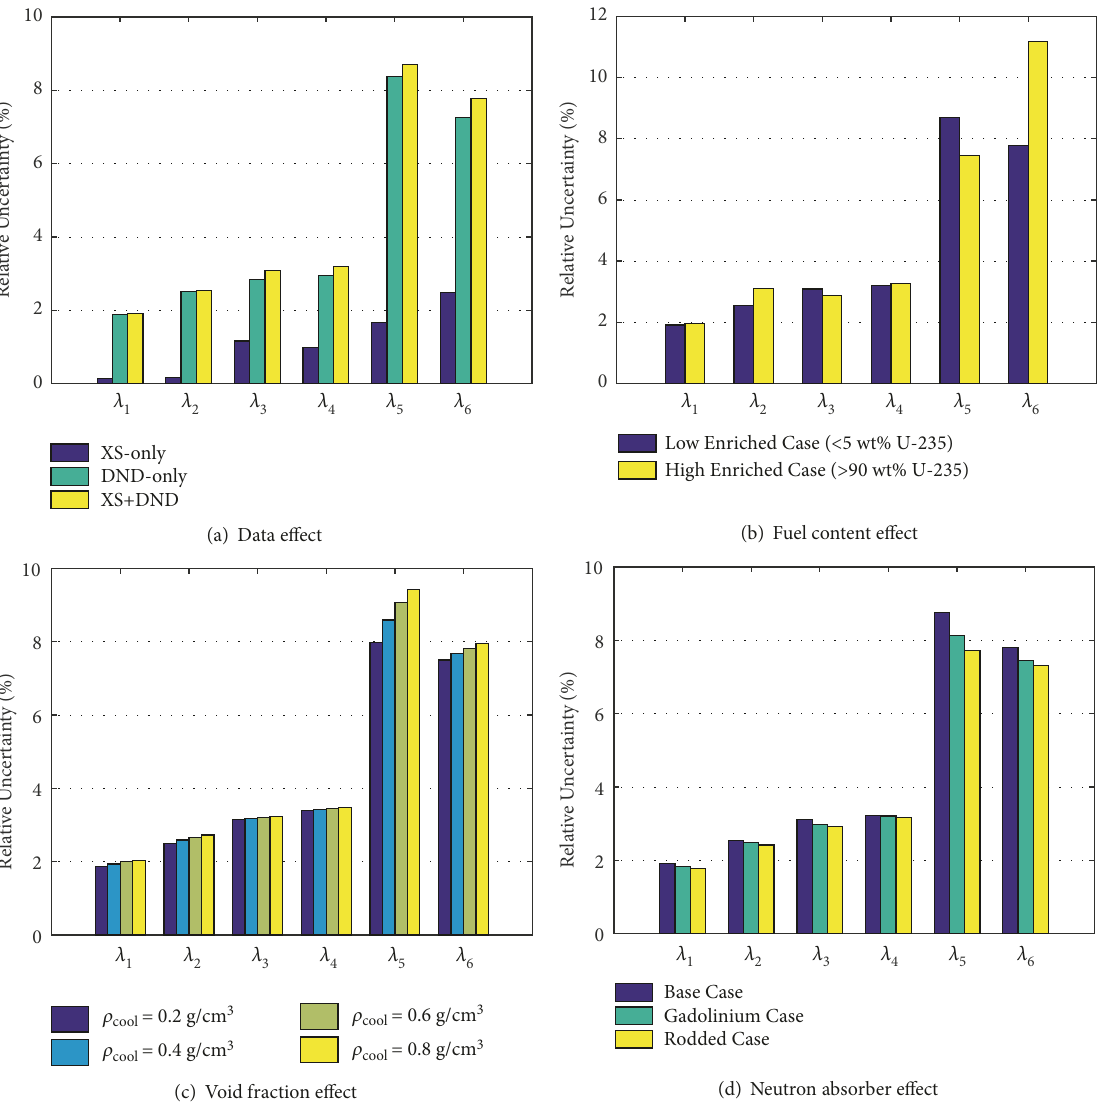
Figure 5: Precursor-group-wise decay constant ( 𝜆 𝑖 ) relative uncertainty (in %) for various sensitivity cases at BOL: (a) data source (PWR pin-cell), (b) initial fuel content (PWR pin-cell), (c) void fraction (BWR lattice), and (d) neutron absorber (PWR